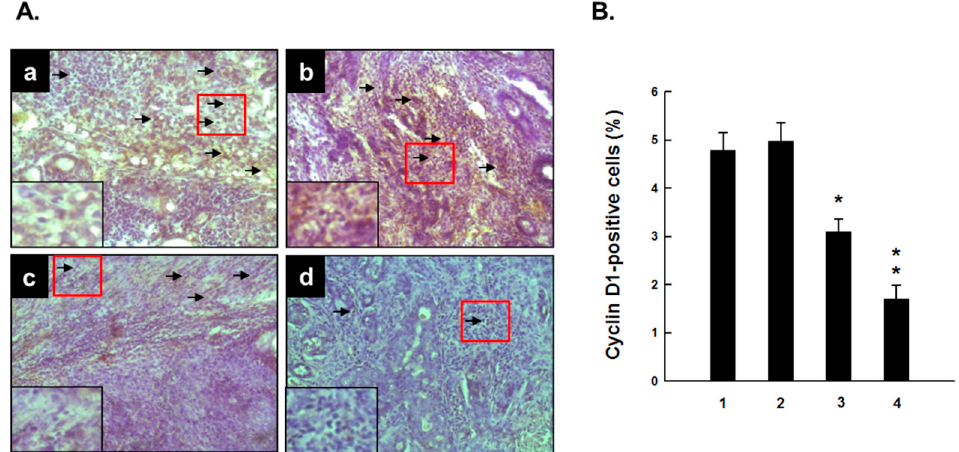
Figure 5. Effect of PE on expression of cyclin D1 during DMBA-inflicted mammary gland tumorigenesis in rats. ( A ) Immunohistochemical detection of cyclin D1 in several experimental rat groups. The rats were treated with various oral doses of PE (three times a week) 2 weeks prior to and 16 weeks after DMBA administration. All animals were sacrificed 16 weeks post-DMBA treatment. The mammary tumors were subjected to immunohistochemical analysis using anti-cyclin D1 antibody. Arrows indicate immunohistochemical localization of cyclin D1 in nucleus (magnification: ×200). The nuclear expression of cyclin D1 in the designated area marked by red box is shown as an inset (magnification: ×1000) for each treatment group. Various treatment groups are: (a) DMBA control; (b) PE at 0.2 g/kg body weight plus DMBA; (c) PE at 1.0 g/kg body weight plus DMBA; and (d) PE at 5.0 g/kg body weight plus DMBA; ( B ) Quantitative analysis of cyclin D1-immunopositive cells in rat mammary tumors induced by DMBA in the presence or absence of PE treatment (0.2, 1.0 or 5.0 g/kg). Results are based on 1000 cells per animal and 4 animals per group. Each bar represents the mean ± SEM ( n = 4). * p < 0.05 and ** p < 0.001 as compared to DMBA control. Various experimental groups are: (1) DMBA control; (2) PE (0.2 g/kg) + DMBA; (3) PE (1.0 g/kg) + DMBA; and (4) PE (5.0 g/kg) +